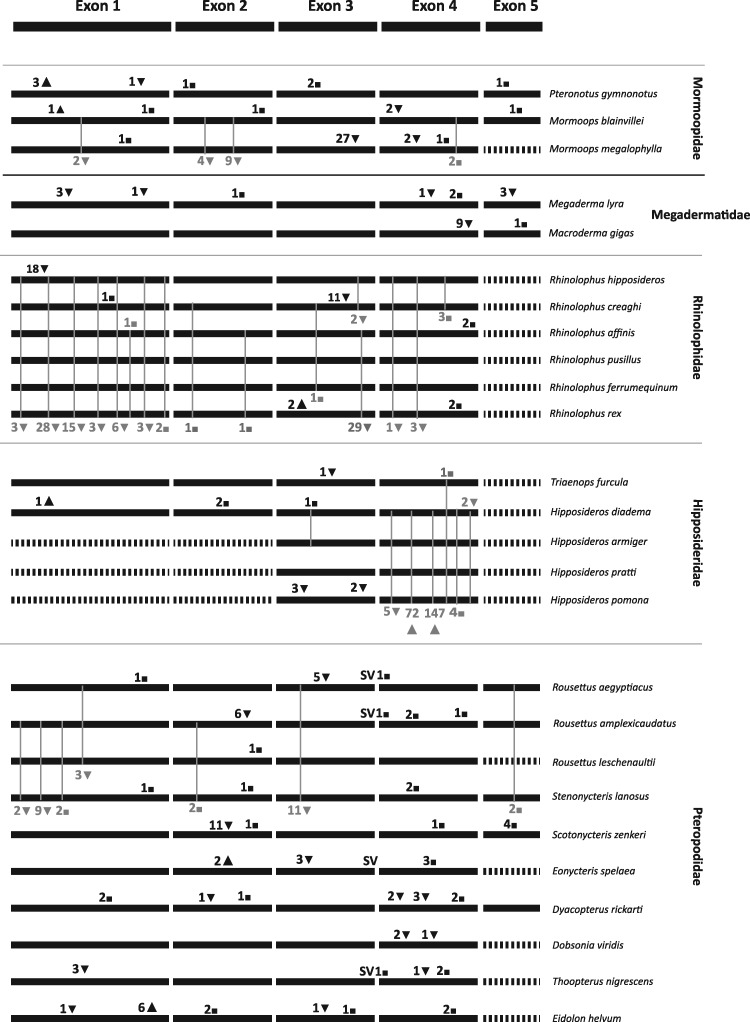
Schematic depicting the shared and private indels leading to frame-shift mutations (insertion ▲, deletion▼), premature stop codons (◼) and loss-of-function mutations in the SWS1 opsin in 26 bats where this gene is nonfunctional.